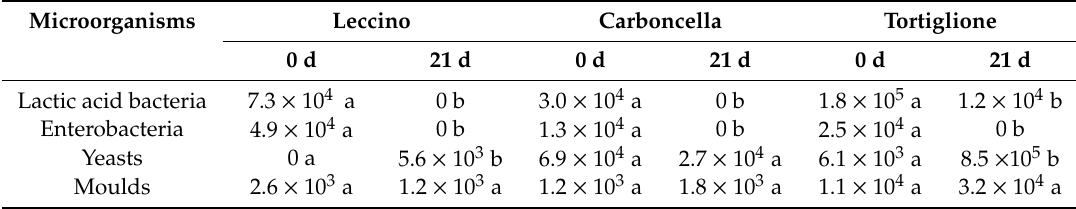
Table 5. Microbial monitoring. Data are expressed in CFU / g. Significant di ff erences are indicated by